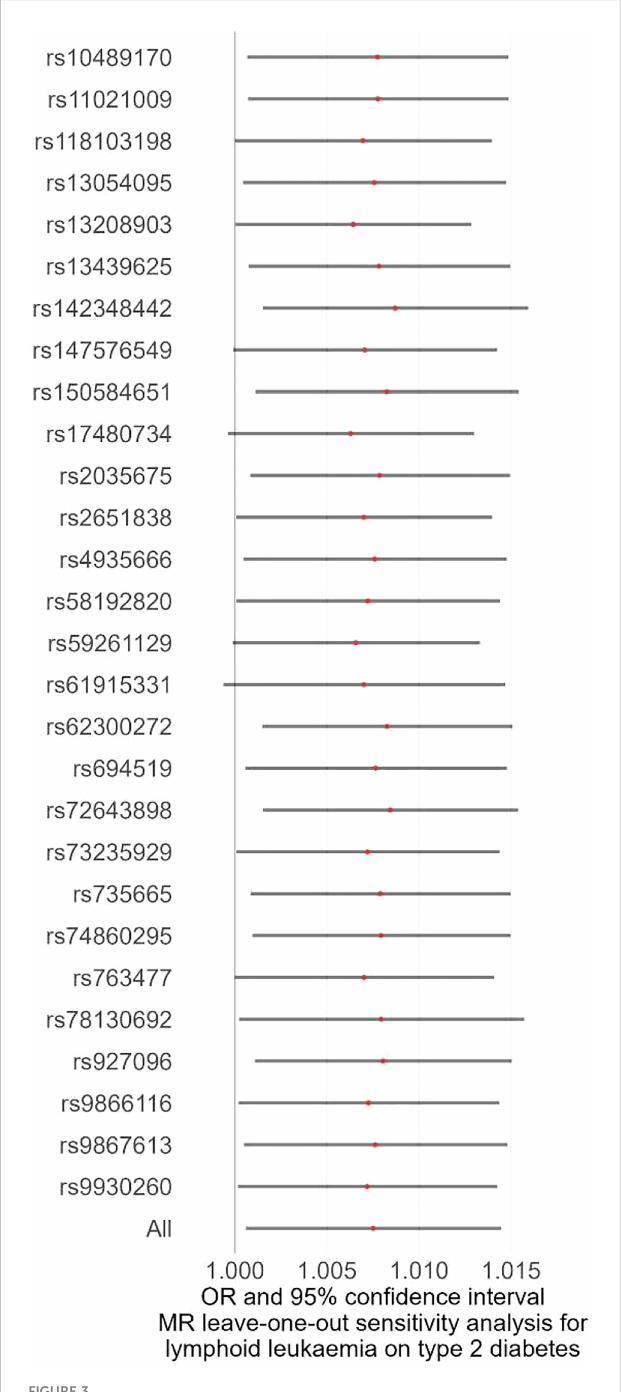
FIGURE 3 Leave-one-out analysis as a sensitivity analysis to examine the causal association between lymphoid leukaemia and diabetes. MR, Mendelian randomization; OR, odds